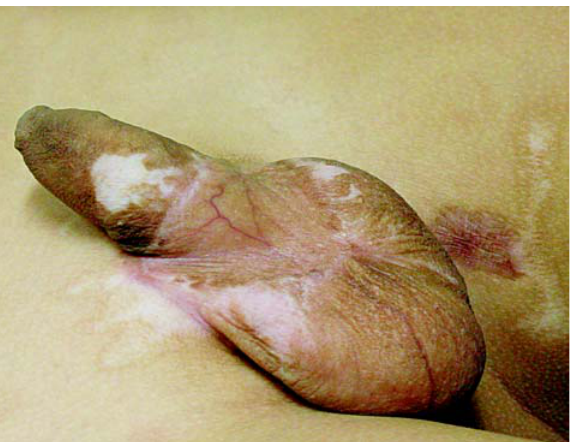
Figure 3 – Aspect of the genitalia 120 days after skin flap.